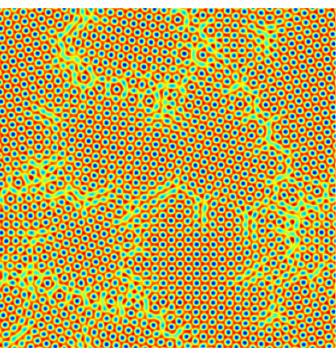
Figure 2. The dynamical behaviors of the phase transition example, where snapshots of the numerical approximation of φ are taken at t = 0, 100, 250, 350, 500, 600, 750, 850, and